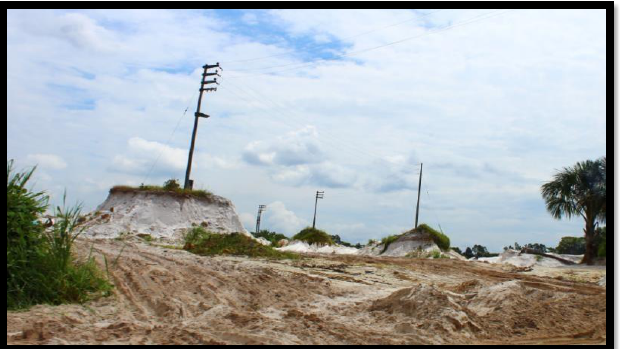
Figure 4: White sand mining concession in AMNR buffer